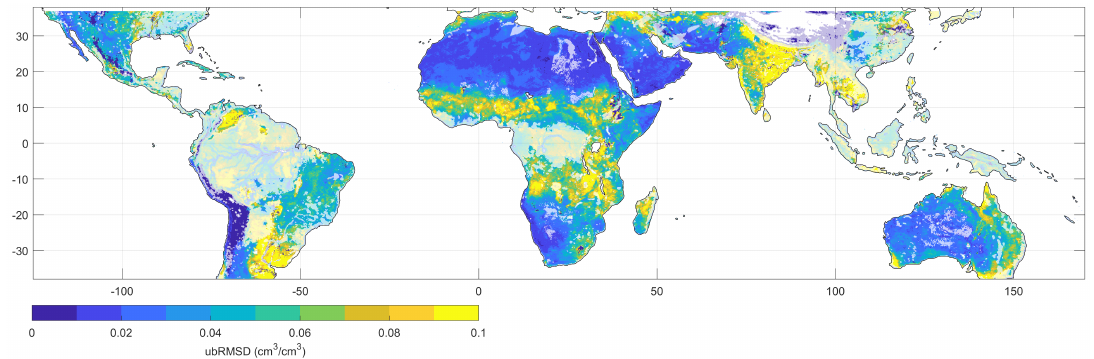
Figure 4. Unbiased root-mean-square difference (ubRMSD) between Cyclone Global Navigation Satellite System (CYGNSS)-based model prediction and SMAP retrievals. Semi-transparent regions are those flagged by SMAP as having uncertain SM retrieval quality.